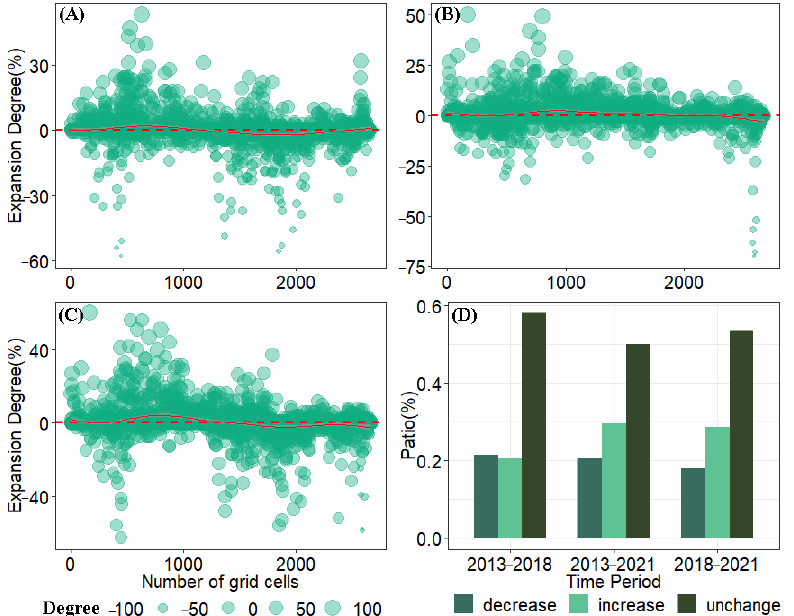
Figure A3. Plot showing the expansion of raft mariculture in the study area at the grid scale including ( A ): 2013–2018, ( B ): 2018–2021, ( C ): 2013–2021, and ( D ): Patio changes in raft mariculture during the different periods.